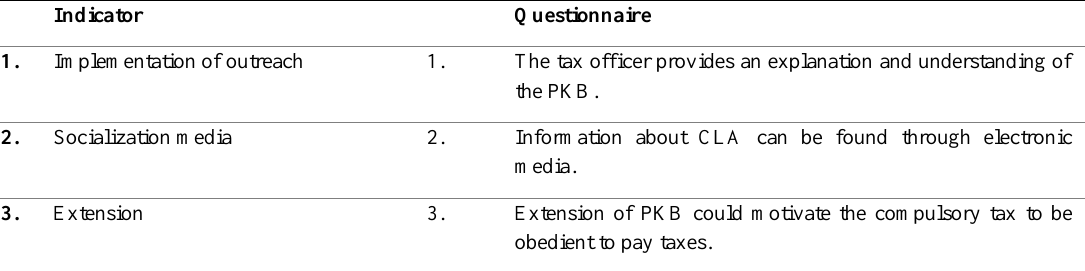
Table 6: Tax Socialization Variable